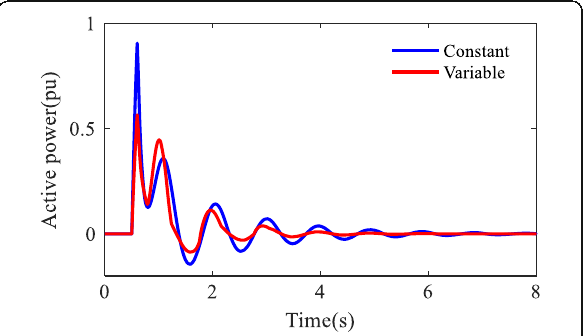
Fig. 12 The Active power output of ESS when the output power of the PV is 0.9